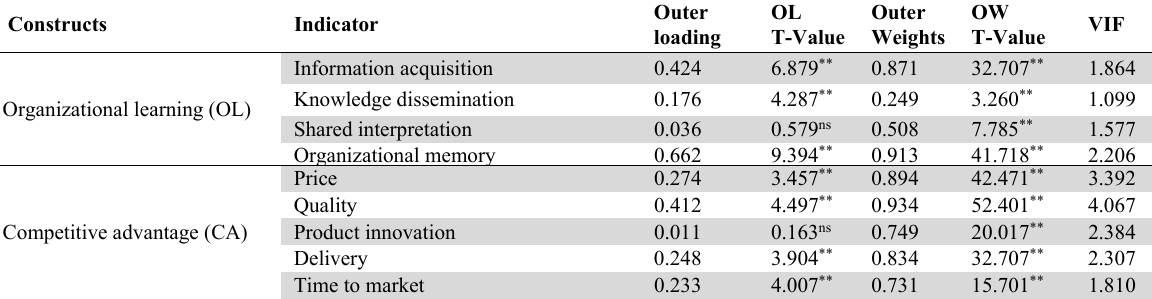
Formative construct (2 nd order) assessment of measurement model Constructs Organizational learning (OL)